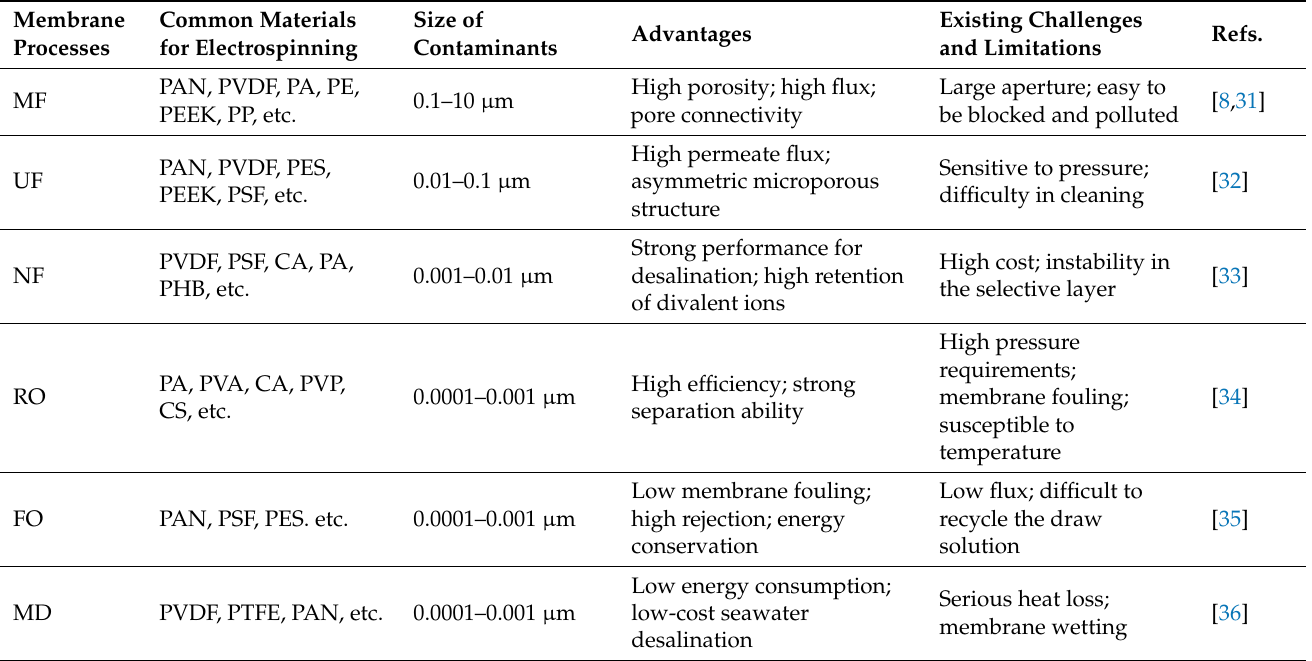
Table 2. The characteristics of different membrane processes based on